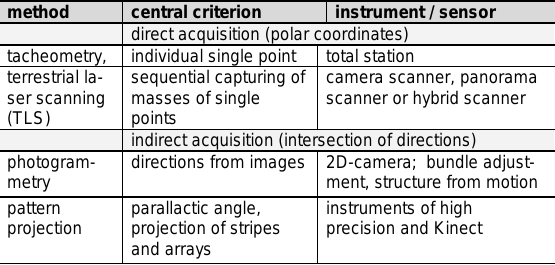
Table 1 Recording methods and their characteristics